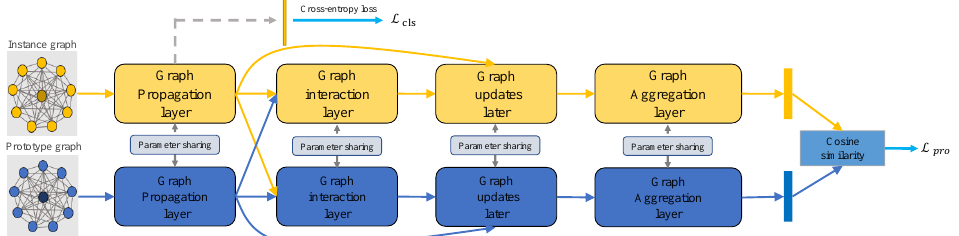
Figure 2. An overall illustration of the graph matching module. The graph matching module is used to propagate information to the nodes of the instance graph and measure the graph-level similarity of the instance graph to the corresponding category diagram